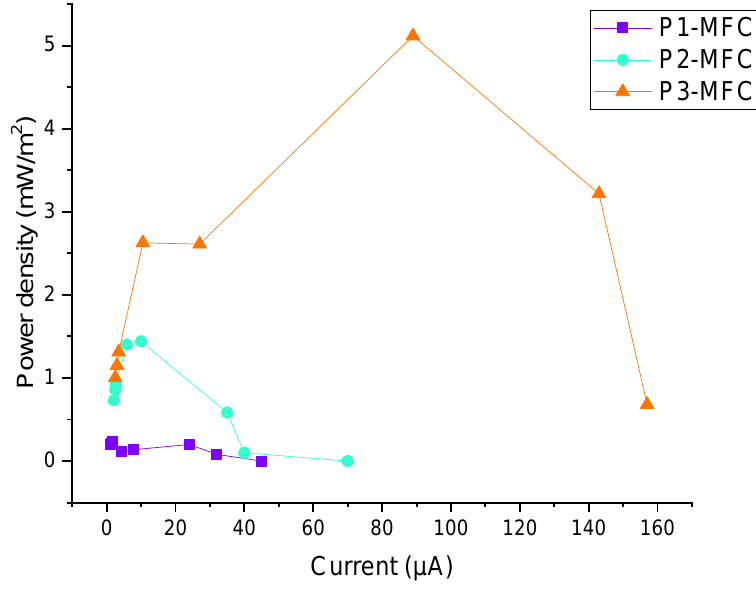
Figure 3. Power density curves of MFCs.